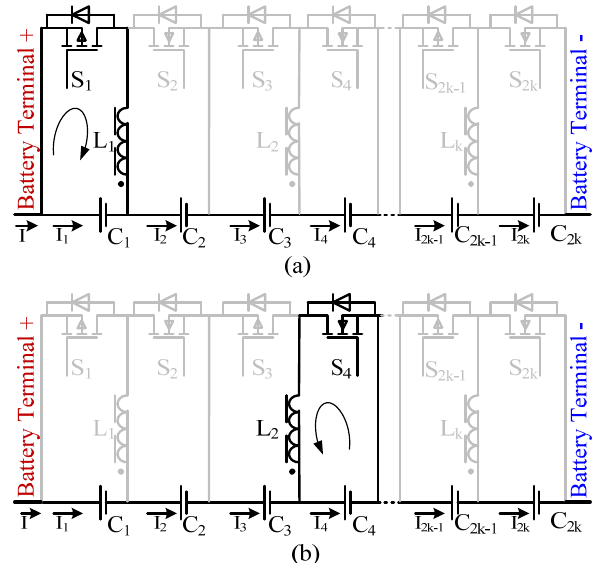
Figure 3. Operational modes of the proposed bidirectional flyback converter